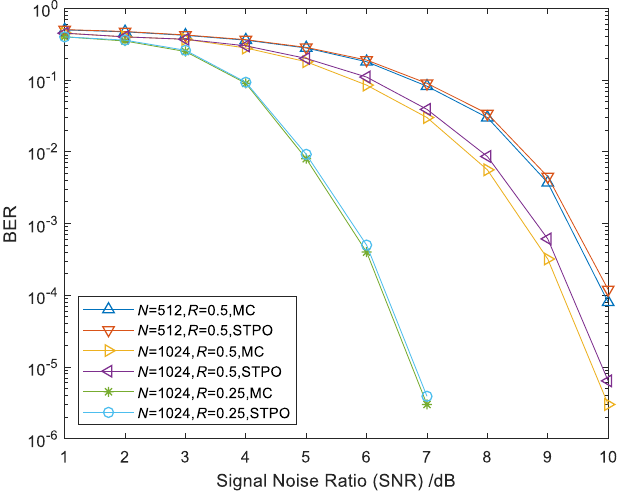
Figure 7. Comparison of bit error rate under different code lengths and code rates.